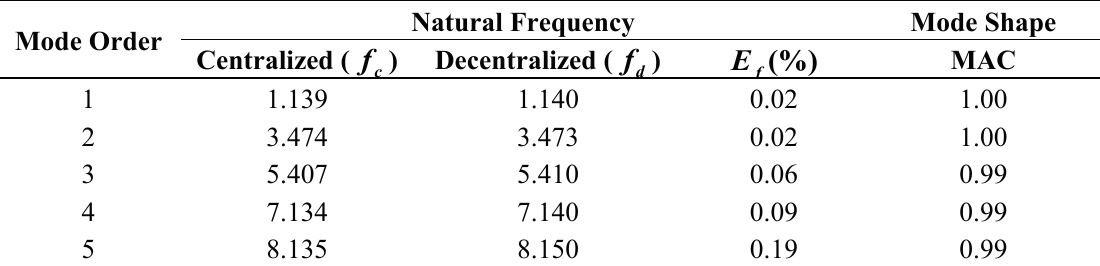
Table 1. Comparison of modal properties from centralized and decentralized data processing